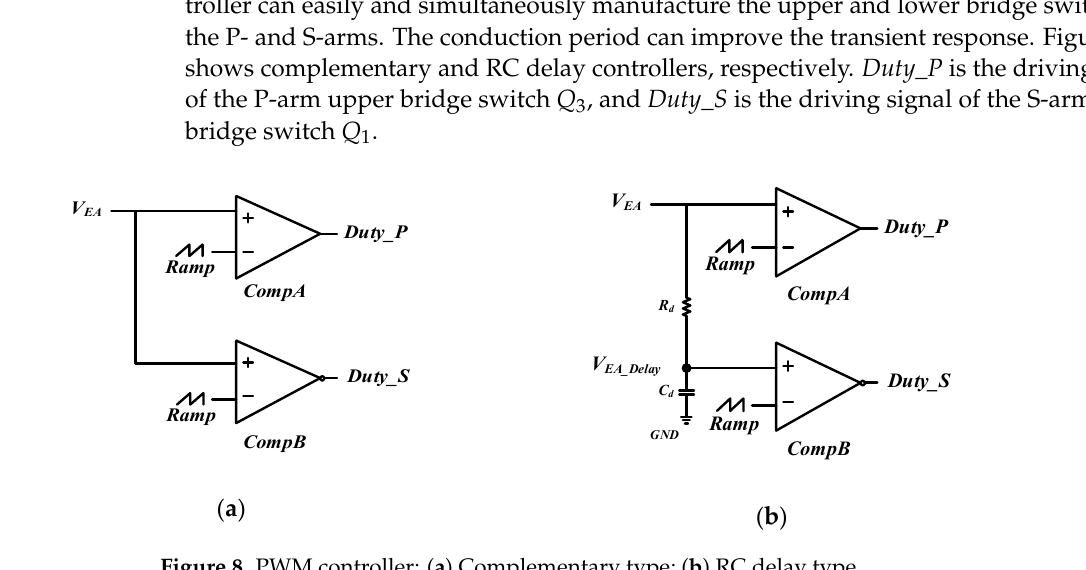
Figure 8. PWM controller: ( a ) Complementary type; ( b ) RC delay type. Figure 9 illustrates the operation sequence diagram of the RC delay type controller.